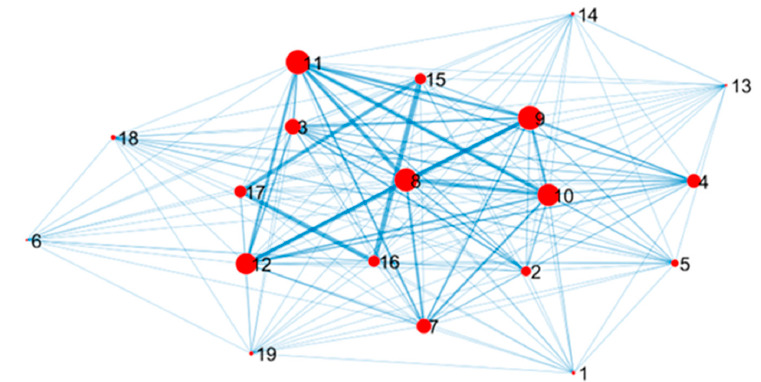
Figure 12. Correlations between the different investigated